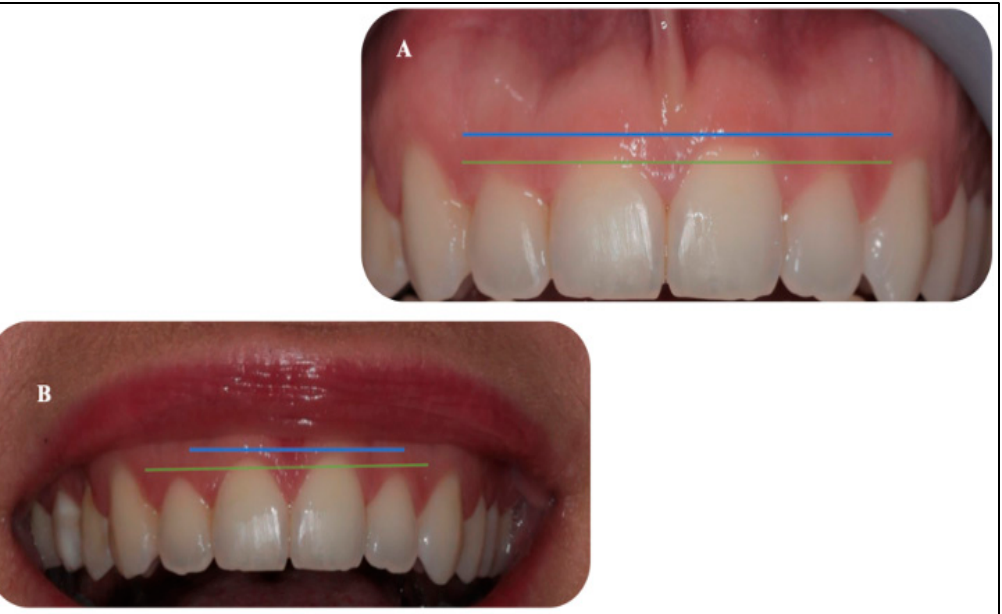
Figure 11. ( A,B ) Illustration of the difference between the gingival overgrowth of the # 11, #12, #21, and #22 pre-operatively photo ( A ) and the (photo ( B )) clinical outcome of the smile line at six-months post-laser gingivoplasty. Blue and green lines show the zeniths of the gingival tissue of #11 and #21, and #12 and #22, respectively. Photo ( B ) shows a great improvement in the gingival zeniths of upper incisors at six months, compared to those taken pre-operatively photo ( A